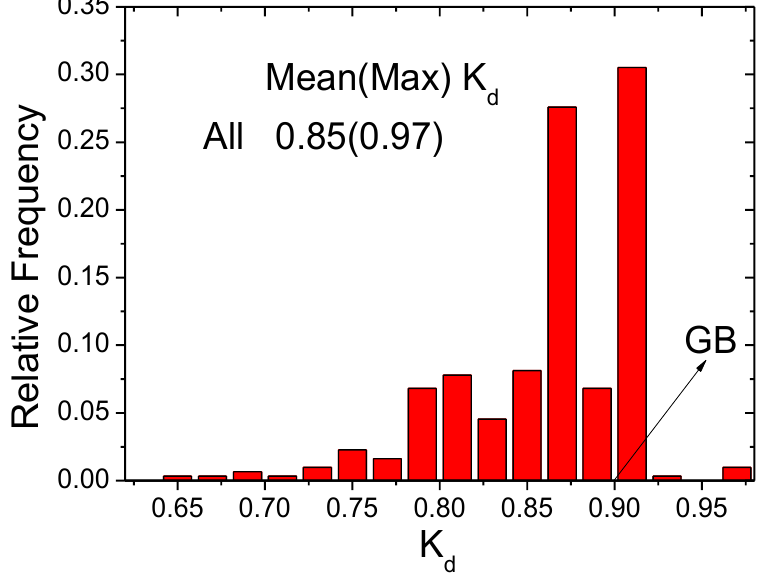
0 . 65 Figure 16. Wind directionality factors at different Figure 16. Wind directionality factors at different taps.